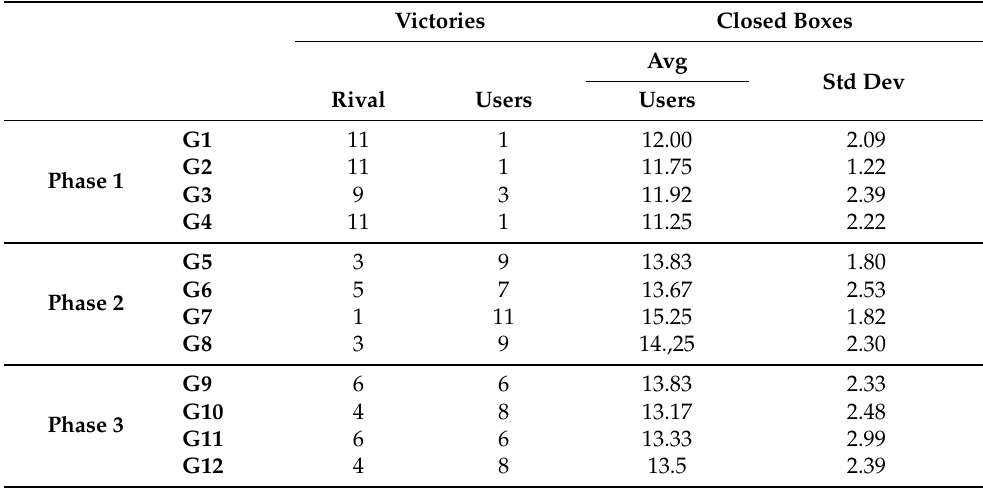
Table 4. Victories and average boxes closed in each game by the participants and the rival system. Victories Closed Boxes Avg